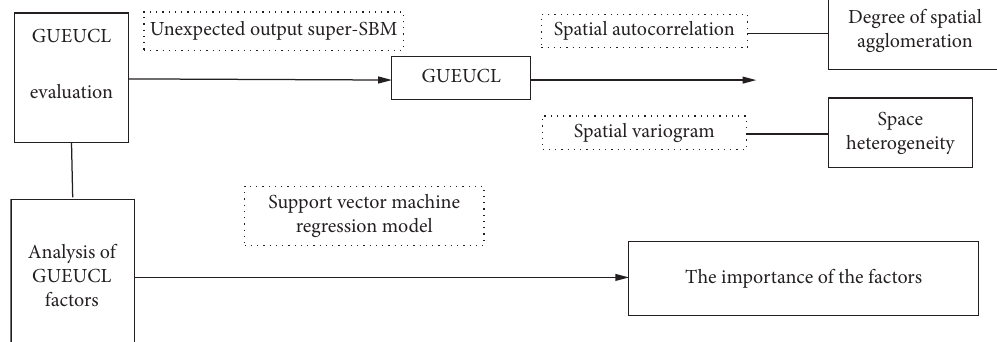
Figure 2: Method flowchart.